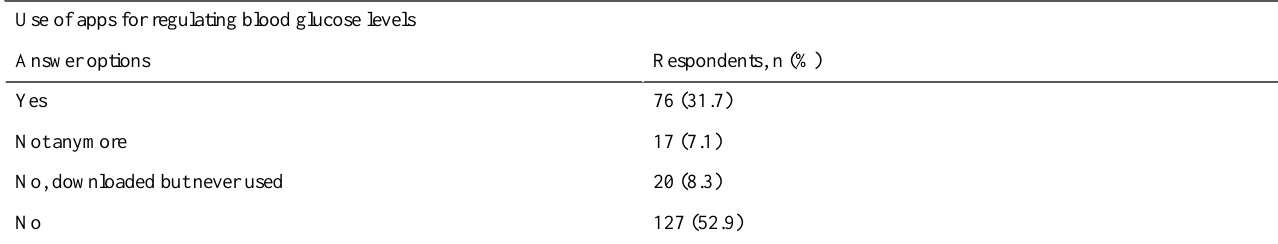
Table 4. Use of apps for regulating blood glucose levels by persons with diabetes; data are presented as percentage of respondents (N=240). Use of apps for regulating blood glucose levels